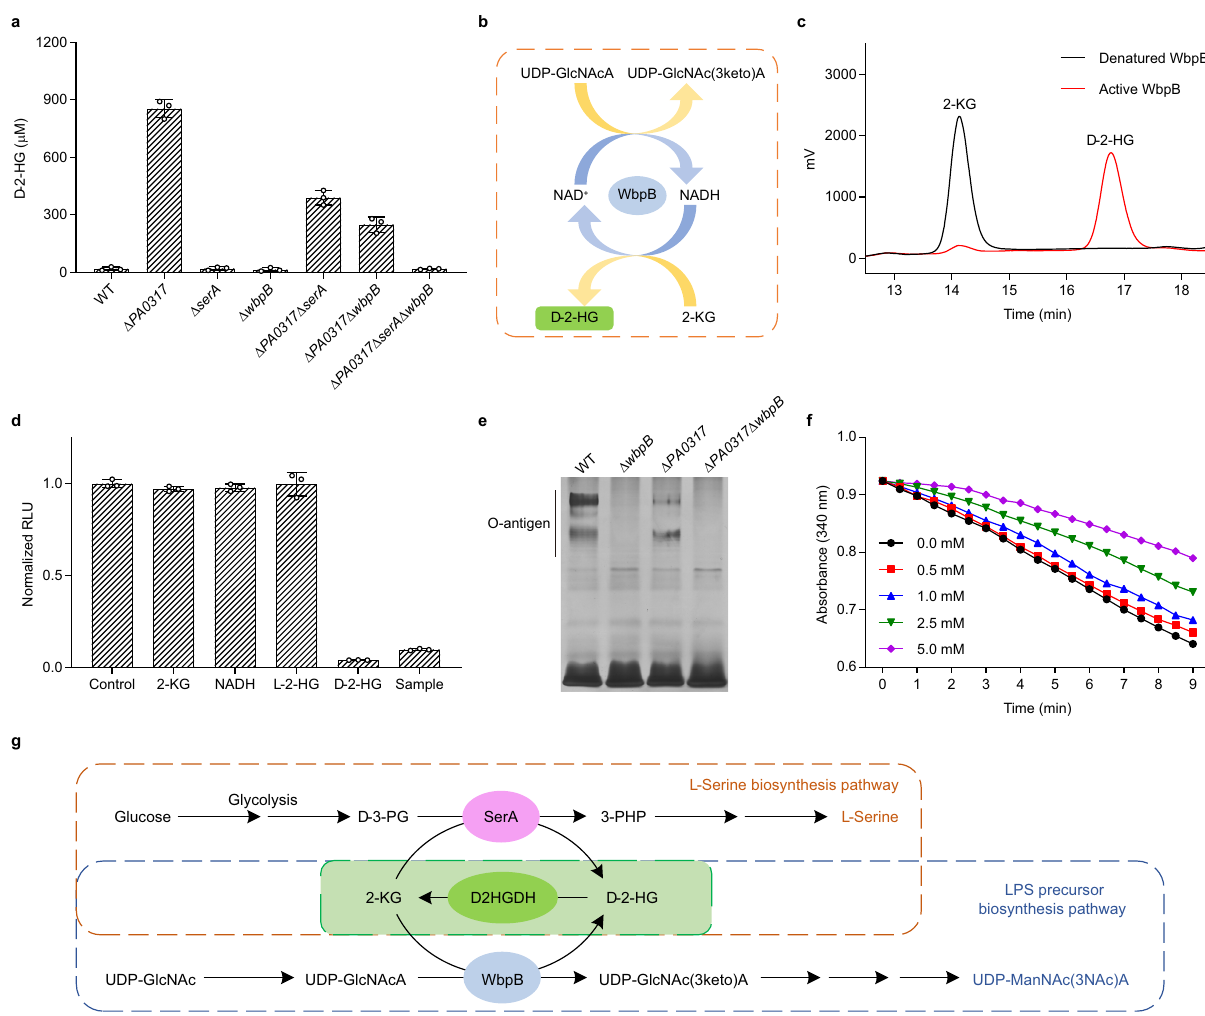
Fig. 6 Identi fi cation of the D -2-HG metabolism pathways in P. aeruginosa PAO1 using B -1. a Determination of extracellular D -2-HG of P. aeruginosa D 2HG PAO1 and its derivatives by B -1. The concentrations of DhdR and Bio- dhdO -1 are 0.3 and 1 nM, respectively. Data shown are mean ± s.d. ( n = 3 D 2HG independent experiments). b Schematic diagram of WbpB-catalyzed coupled reaction. c HPLC analysis of the product of WbpB-catalyzed 2-KG reduction. The reaction mixtures containing 2-KG (5 mM), NADH (5 mM), and active or denatured WbpB (0.4 mg mL − 1 ) in 50 mM Tris-HCl (100 mM NaCl, pH 7.4) were incubated at 37 °C for 3 h. Black line, the reaction with denatured WbpB; red line, the reaction with active WbpB. d Chiral analysis of WbpB produced 2-HG by B -1. The concentration of 2-KG, NADH, L -2-HG, and D -2-HG is 20 μ M. The concentrations of DhdR and Bio- dhdO -1 were 0.3 and 1 nM, D 2HG respectively. The sample is 50-fold diluted WbpB-catalyzed product. Data shown are mean ± s.d. ( n = 3 independent experiments). e SDS-PAGE analysis of LPS of P. aeruginosa PAO1 and its derivatives. f Inhibitory of D -2-HG toward WbpB. The reaction mixtures containing WbpB (0.3 mg mL − 1 ), 2-KG (0.5 mM), NADH (200 μ M), and 0 – 5 mM D -2-HG in 50 mM Tris-HCl (100 mM NaCl, pH 7.4) were incubated at 37 °C for 9 min. g D -2-HG metabolism pathways in P. aeruginosa PAO1. The coupling between D2HGDH and SerA or D2HGDH and WbpB makes the robust interconversion between D -2-HG and 2-KG, and facilitates the biosynthesis of L -serine (orange dotted box) and precursor of LPS in P. aeruginosa PAO1 (blue dotted box). Source data are provided as a Source Data fi